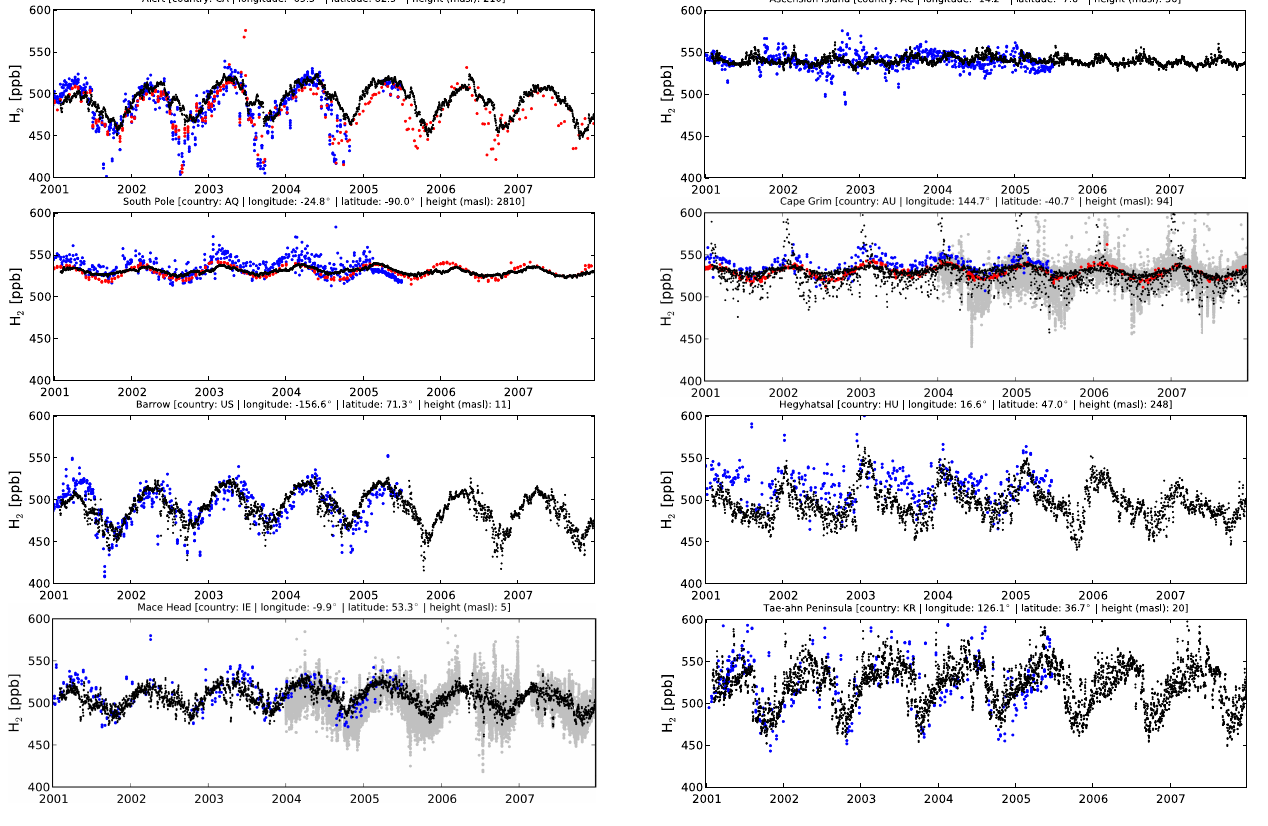
Fig. 2. Comparison between the measured and modelled (black) noon-time H 2 mixing ratios at Ascension Island, Cape Grim, Hegy- hatsal and the Tae-Ahn peninsula. Available measurements from NOAA, CSIRO and AGAGE are shown in blue, red, and grey, re- spectively. Measurements from AGAGE are shown without filtering for background